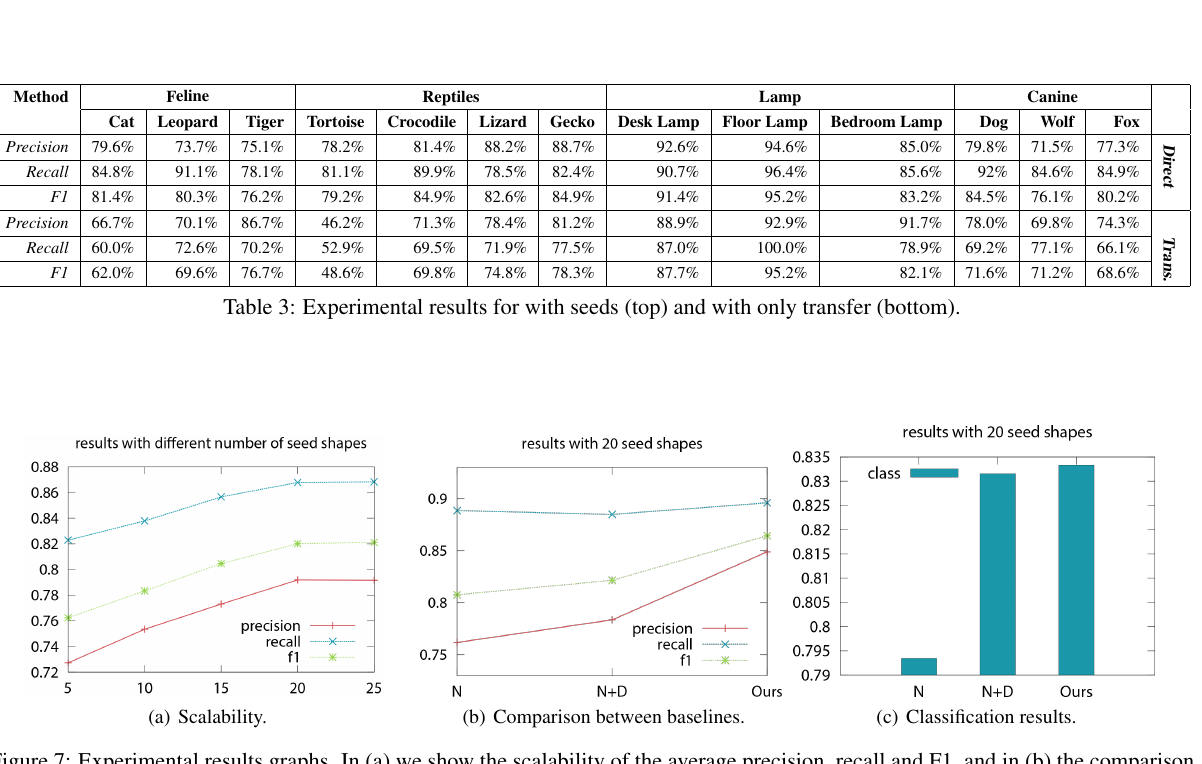
Figure 7: Experimental results graphs. In (a) we show the scalability of the average precision, recall and F1, and in (b) the comparison with other baselines. In (c) we show classification precision comparison with other